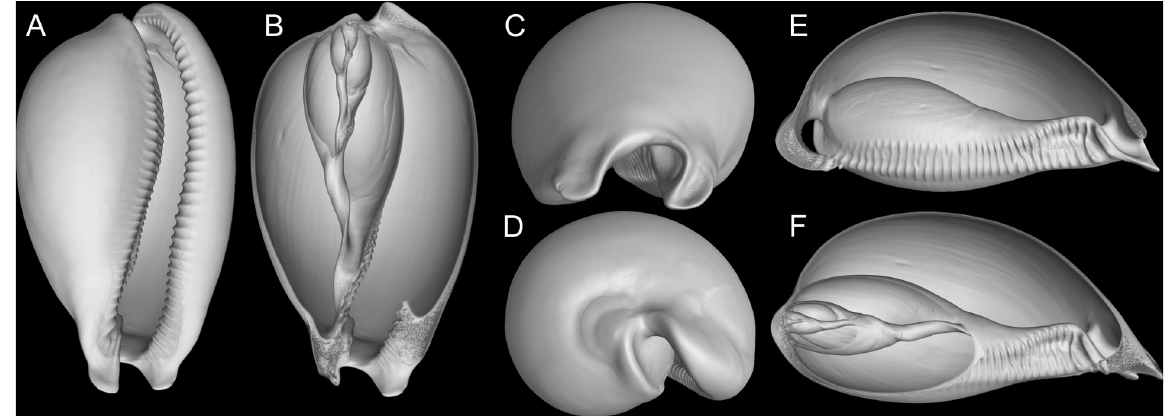
Fig 11. Macrocypraea cervus , 3D reconstructions of shell (CT-Scan) MZSP 121238 (L 98.5 mm). (A) Frontal view. (B) Same, more ventral portions removed. (C) Anterior view.(D) Posterior view. (E), Right view, right half removed. (F) Same, longitudinal section along columellar